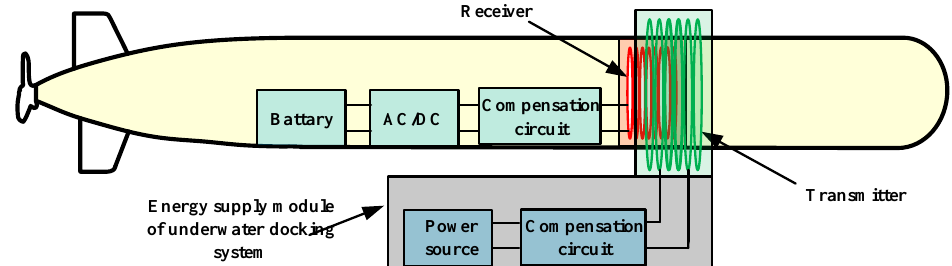
Figure 1. The example of wireless power transfer (WPT) system for autonomous underwater vehicles (AUV).